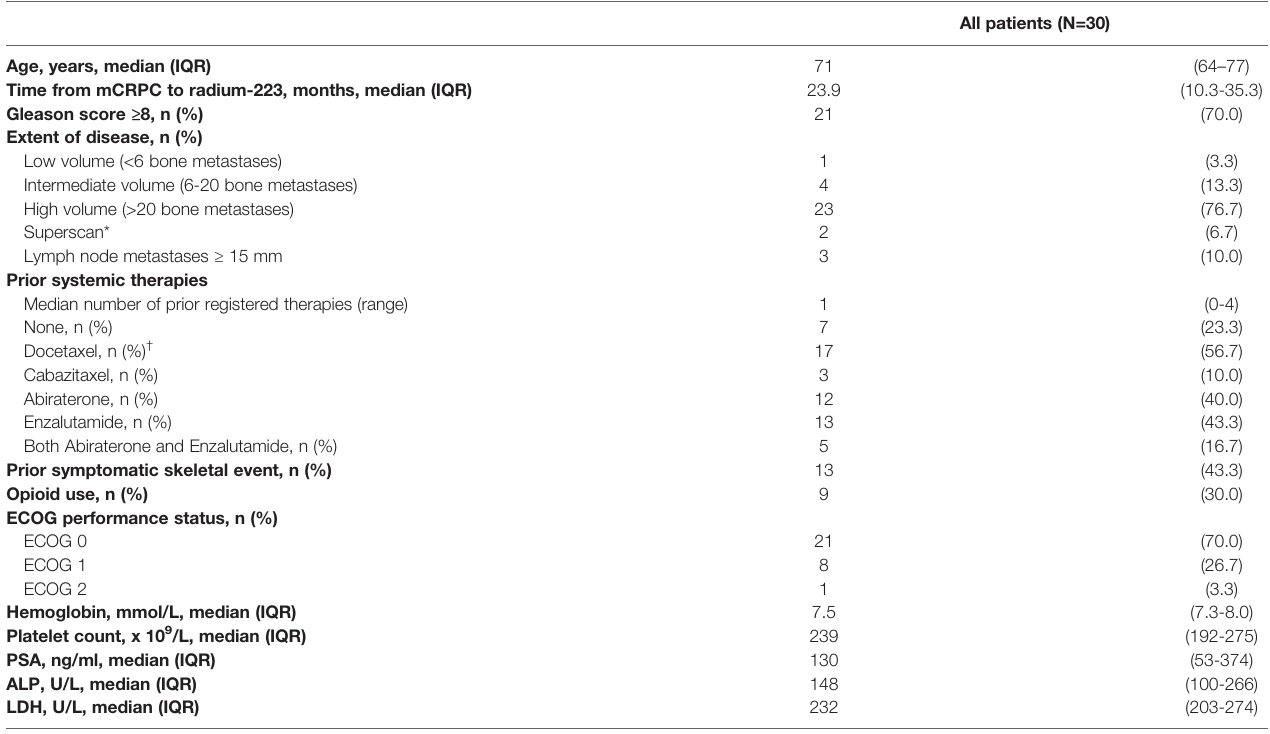
TABLE 1 | Baseline patient demographics and clinical